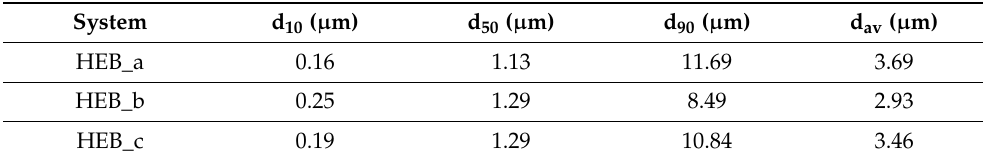
Table 3. Particle size characteristics, as determined by laser scattering analysis, of HEB powders obtained by SHS after the ball milling treatment (CR = 2, 1